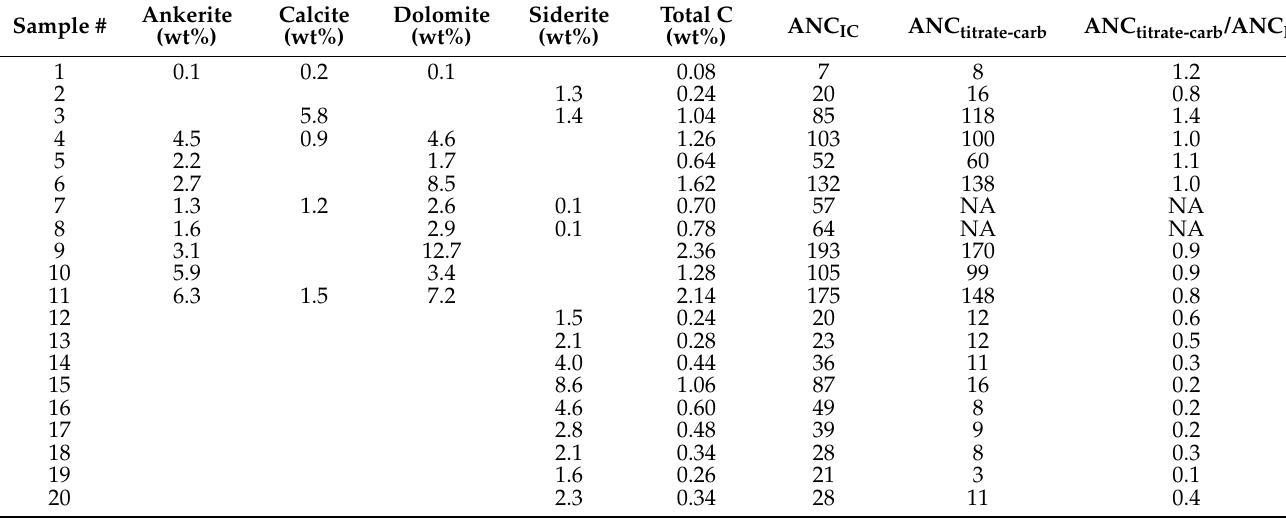
Table 5. Quantitative MLA mineral composition analysis (wt%) of the 20 mine site samples. Total carbon assays have been used to calculate ANC IC (note: it is assumed that there is no organic C). ANC titrate-carb (titration methodology (2)) values are also provided. All ANC values are in units of kg H 2 SO 4 t − 1 . NA—not available. Where a specific mineral (ankerite, calcite or dolomite) was not identified as being present the cell has been left